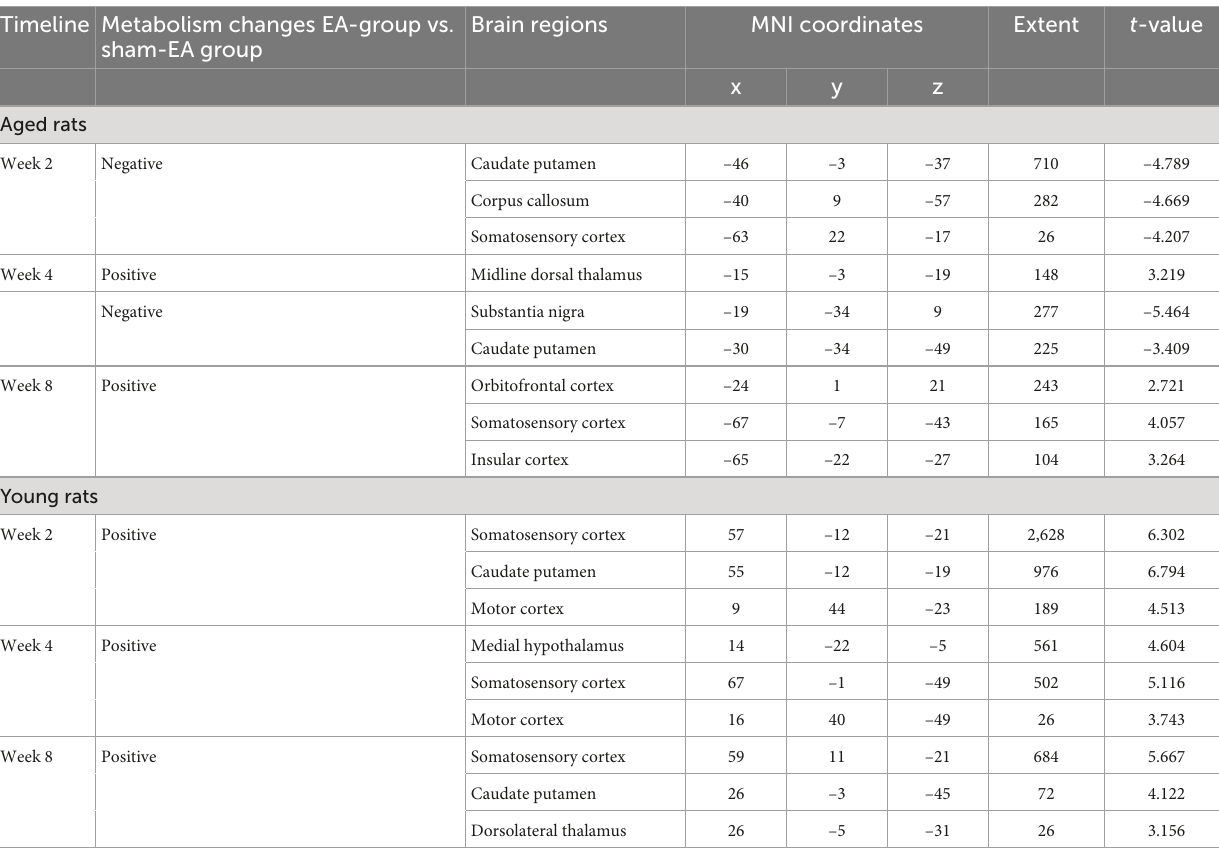
TABLE 1 Sensorimotor brain regions of aged and young rat significant metabolism changes in metabolic activities on week 2, 4, and 8 after electroacupuncture intervention. Timeline Metabolism changes EA-group vs. sham-EA